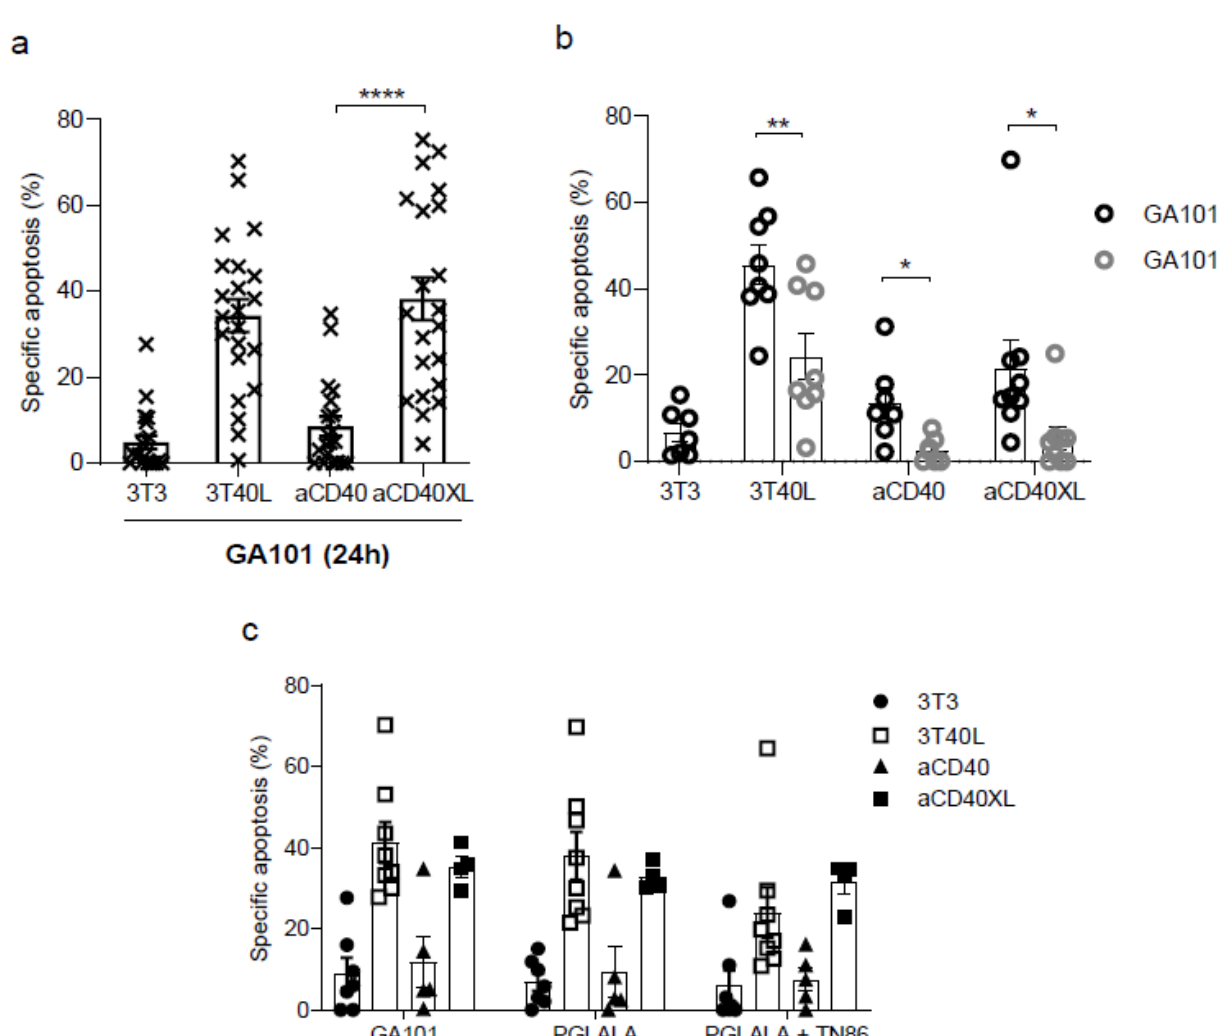
Figure 6. Crosslinked selicrelumab can sensitize CLL cells for cell death induced by anti-CD20 mAb GA101, as well as for the Fc mutated version GA101-P329GLALA. A,B,C CLL cells were cultured and CD40 stimulated as previously described for 48 h. ( a ) After stimulation, cells were incubated with GA10 for 24 h, viability was measured as previously described and specific apoptosis was calculated ( n = 22). Results revealed no differences between IGHV mutated and unmutated patients (non-significant for 3T40L, aCD40 and aCD40XL stimulation). ( b ) Stimulated CLL cells were incubated in the presence/absence of bafilomycin for 1 h and treated with GA101 for 24 h ( n = 7 ≤ 9). ( c ) Stimulated CLL cells were incubated with GA101 and GA101-P329GLALA in the presence of specific crosslinker reagent TN86 for 24 h ( n = 5 ≤ 8). Bars represent the mean ± SEM: * p <0.05, ** p <0.01, **** p <0.0001 (unpaired t